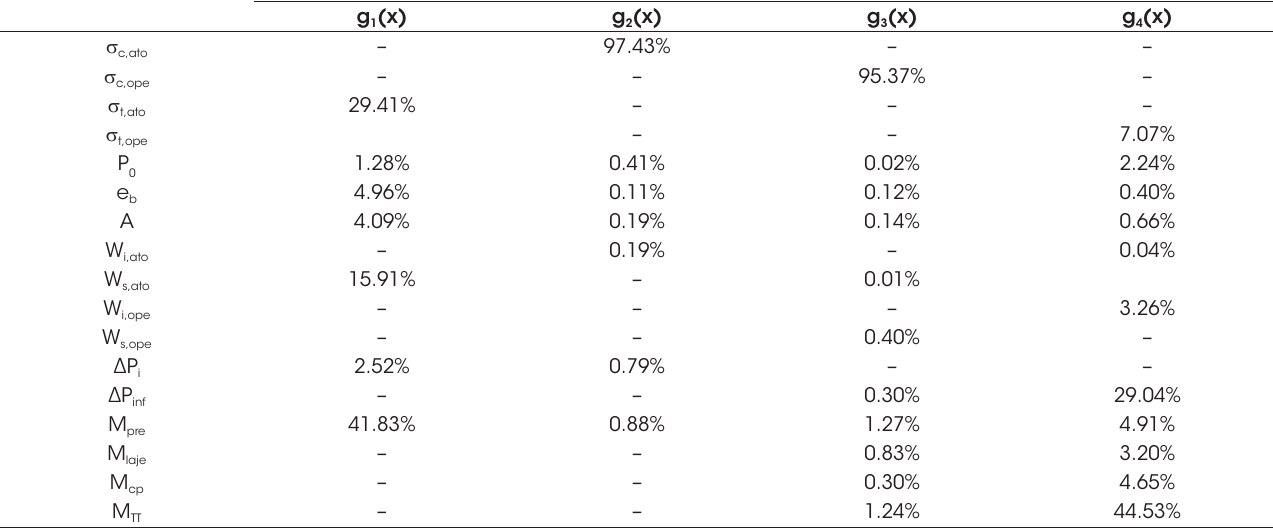
Sensibility analysis of random variables on annual serviceability reliability indices for each limit state